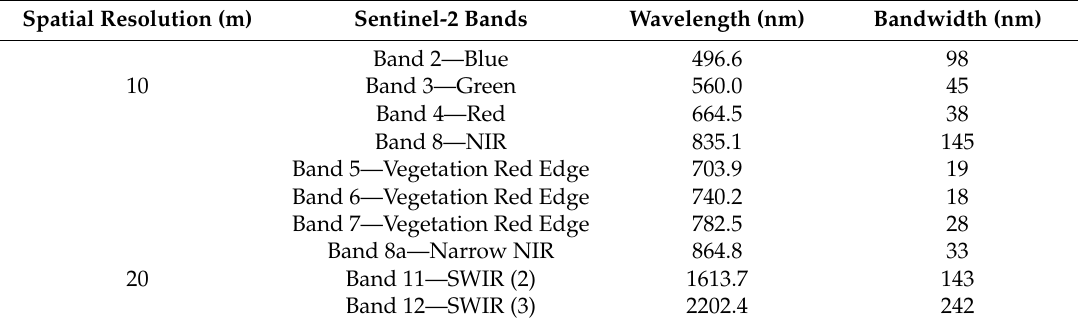
Table 1. Sentinel-2 bands used in this